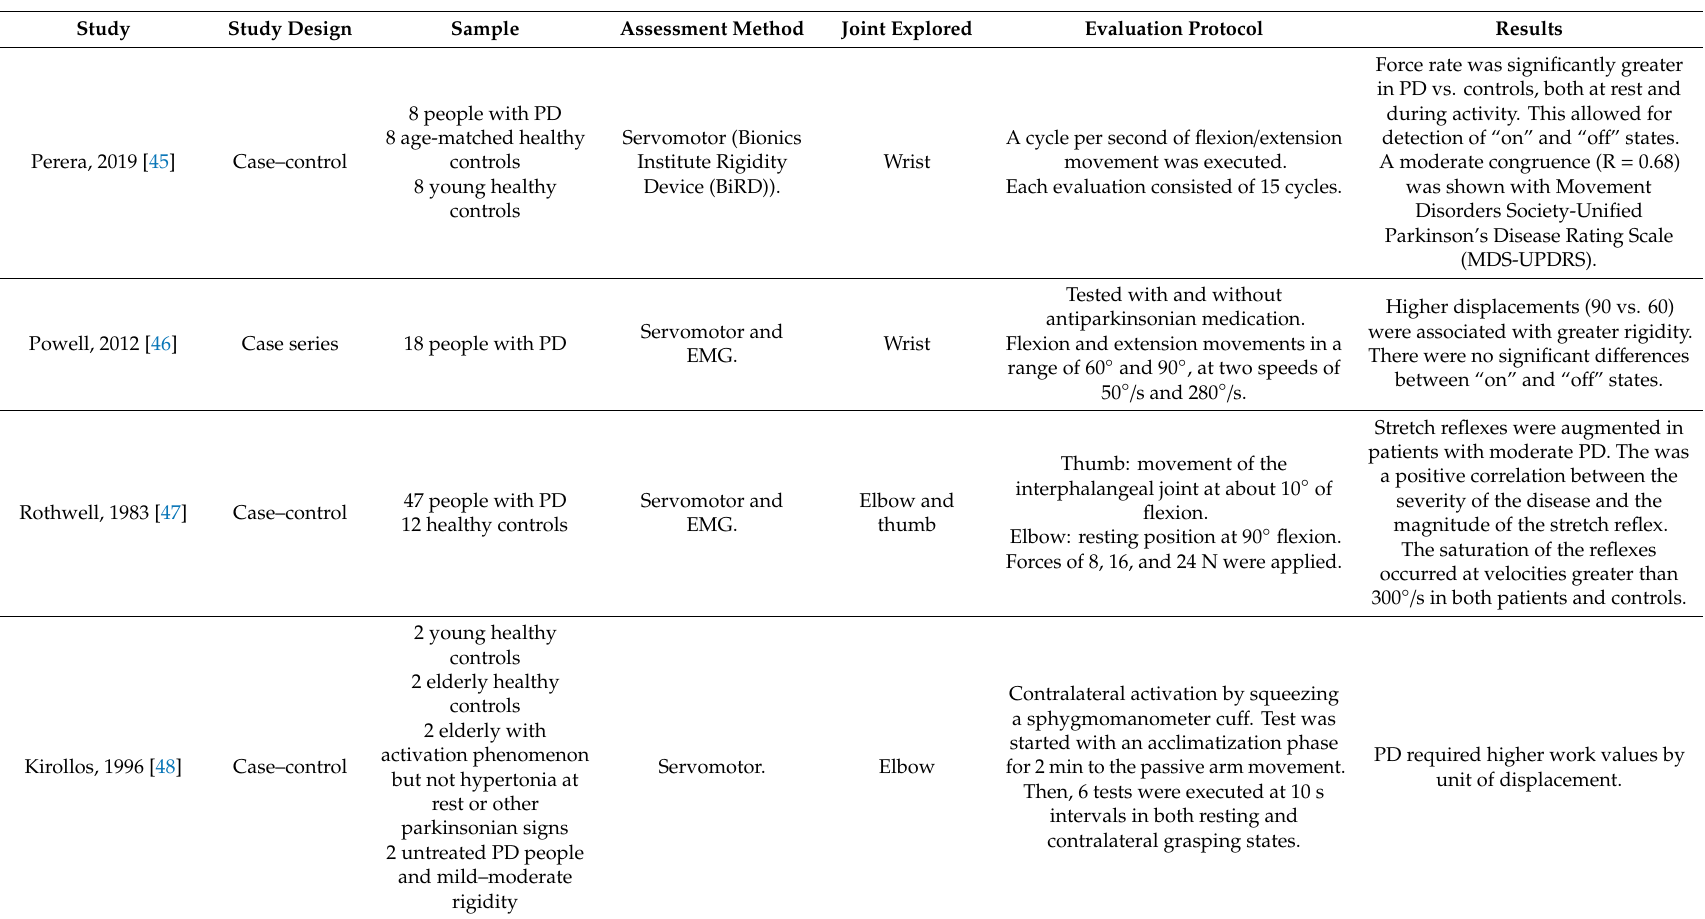
Thumb: movement of the interphalangeal joint at about 10 ◦ of flexion. Elbow: resting position at 90 ◦ flexion. Forces of 8, 16, and 24 N were